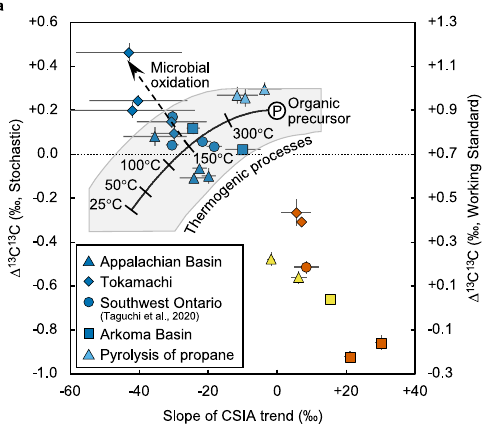
thermal cracking model 21 – 23,26 (see Methods). The grey shaded area shows the uncertainty of the calculation, mainly derived from the possible range in Δ 13 C 13 C and differences in δ 13 C values between two adjacent positions of precursor mole- cules for the thermogenic hydrocarbons (see Methods). The dotted arrow shows the expected change due to microbial oxidation of ethane for Tokamachi mud volcano (Supplementary Fig. 2). b The curved black line shows the theoretically calculated Δ 13 C 13 C value of ethane at each temperature (Supplementary Fig. 3 and Supplementary Table 5) and δ 13 C values of hydrocarbons 67,68 (see Methods). The dotted arrows show the notional changes due to isotope exchange among hydro- carbons after